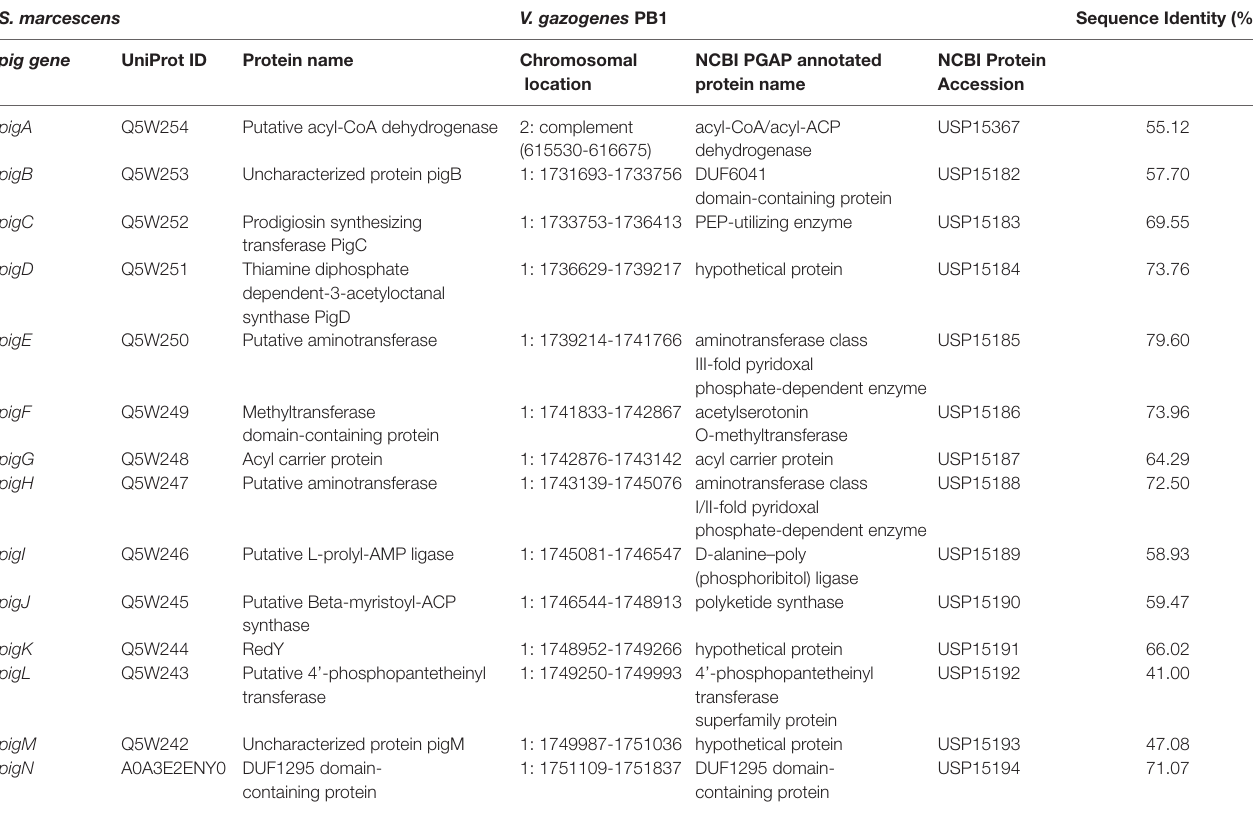
TABLE 1 | Identification of putative pig genes in the V. gazogenes PB1 genome based on annotated pig genes in S. marcescens